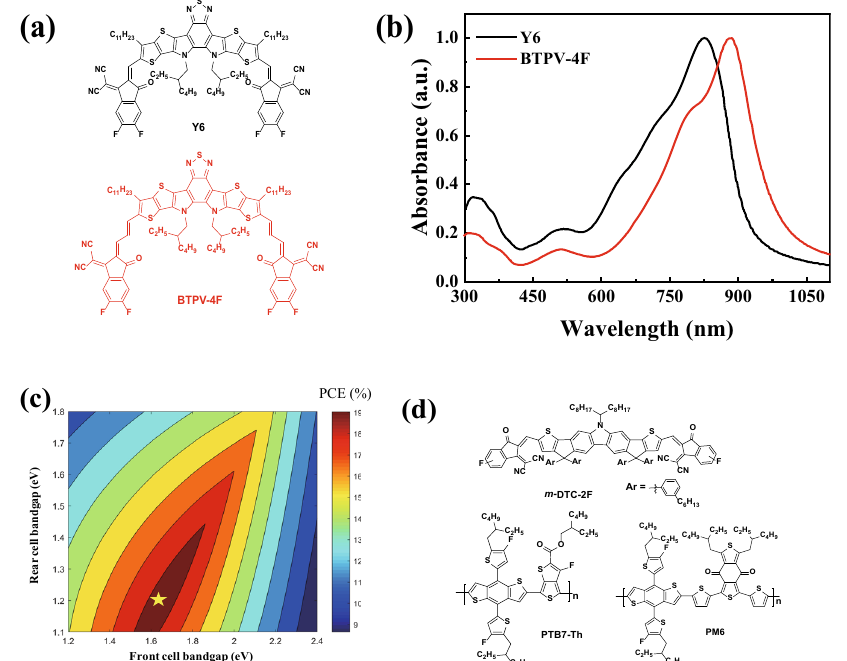
Fig. 1 Materials design and characterization. a Molecular structures of the acceptors BTPV-4F and Y6. b Absorption spectra of the BTPV-4F and Y6 fi lms. c Simulated optimal bandgap matching of two sub-cells in tandem OSCs. d Molecular structures of the acceptor m -DTC-2F and the polymer donors PTB7- Th and